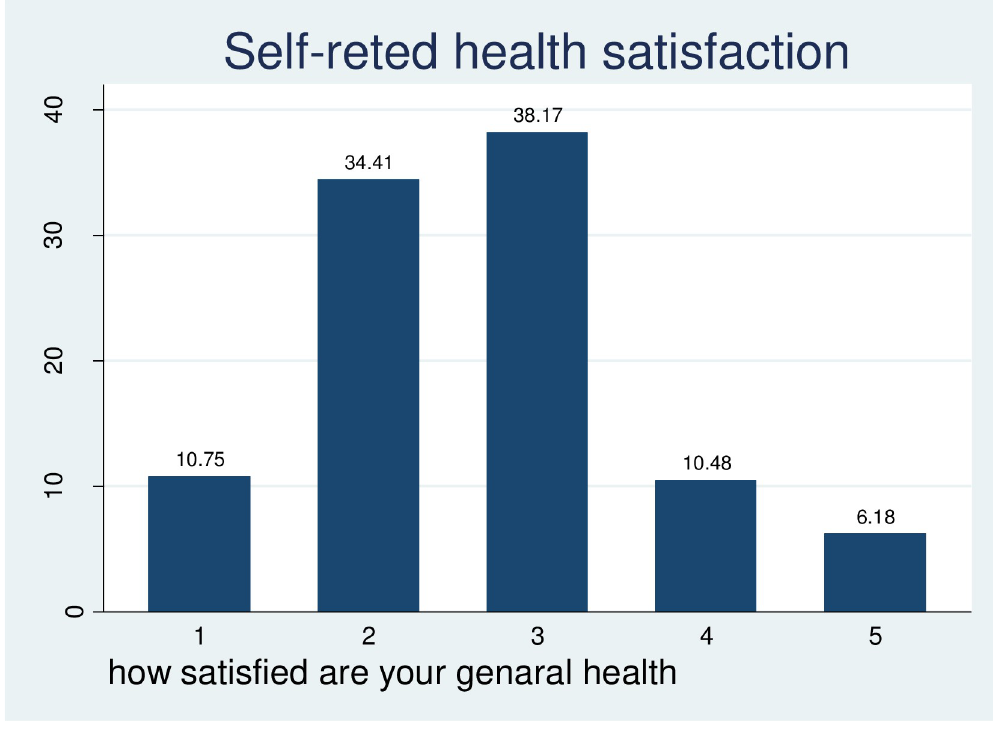
Fig 3. Perceived self-rated health satisfaction of substances used by youths in central Gondar zone, 2021.